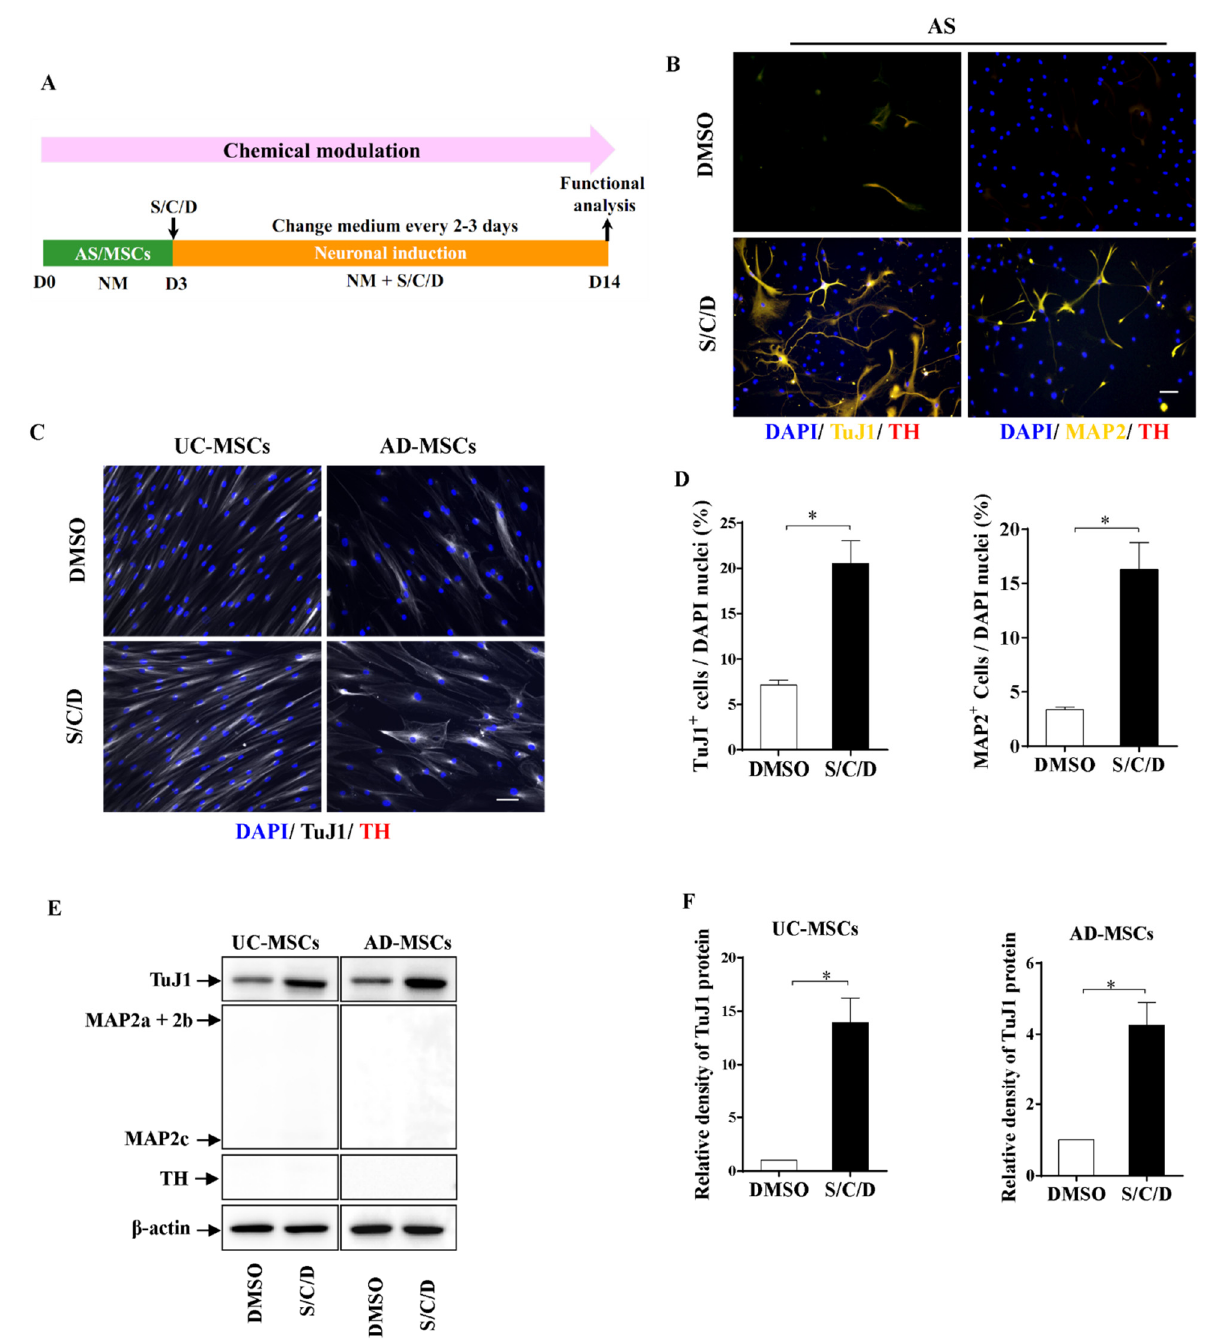
Figure 3. AS and MSCs acquired neuronal phenotypes under chemical modulation. ( A ) The paradigm of chemical modulation. AS, UC-MSCs, or AD-MSCs was primed in NM for 3 days, followed by induction with chemicals SB431542, CHIR99021, and DAPT (S/C/D). On the 14th day, cells were fixed and analyzed by immunostaining or WB. ( B ) Representative immunostaining images of DMSO-treated (upper panel) and S/C/D-treated AS (lower panel). There are many cells expressing TuJ1 or MAP2 in the S/C/D-treated AS, markers of the immature and mature neurons, respectively. In contrast, few cells expressed these two markers in the DMSO-treated AS. None of the TH-positive DA neurons could be observed in the DMSO- or S/C/D-induced AS culture. ( C ) Representative images of DMSO-treated (upper panel) and S/C/D-treated MSCs (lower panel) subjected to TuJ1 and TH double immunostaining. Both UC-MSCs (left column) and AD-MSCs (right column) showed no obvious changes in cell morphology, albeit increasing TuJ1 expression pattern after S/C/D treatment. None of the TH + cells could be detected in the MSCs. ( D ) Quantification analysis revealed that S/C/D treatment significantly increased the percentages of TuJ1-positive cells and MAP2-positive cells in the AS culture, as com- pared to the DMSO-treated group ( n = 3 independent experiments). ( E ) Immunoblotting assay for TuJ1 (50 kDa), MAP2